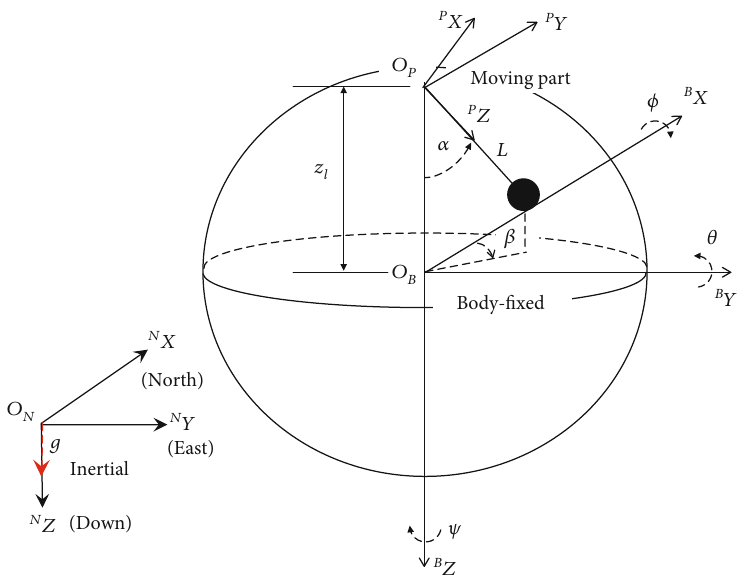
Figure 2: Con fi guration of the